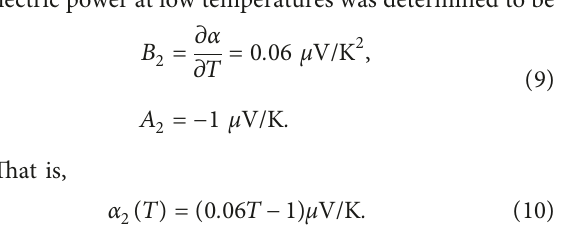
Figure 5: Low-temperature DC conductivity of TlFe ( 1 ), 0.025 ( 2 ), and 0.1 ( 3 ).